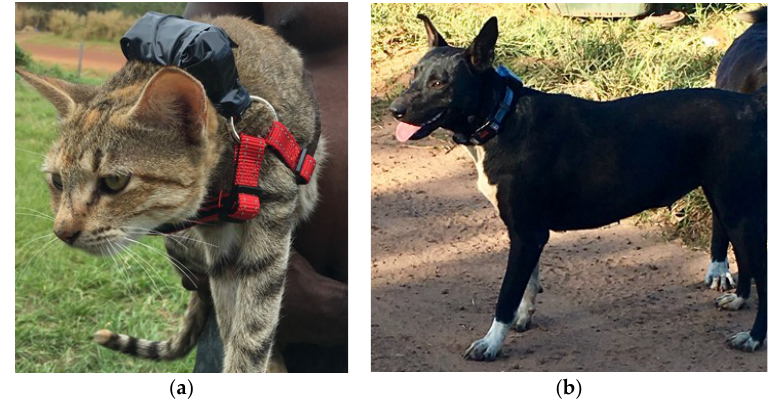
Figure 2. To monitor roaming behaviour and interspecific interaction, igot-U GPS loggers were attached to ( a ) harnesses on cats and ( b ) collars on dogs.